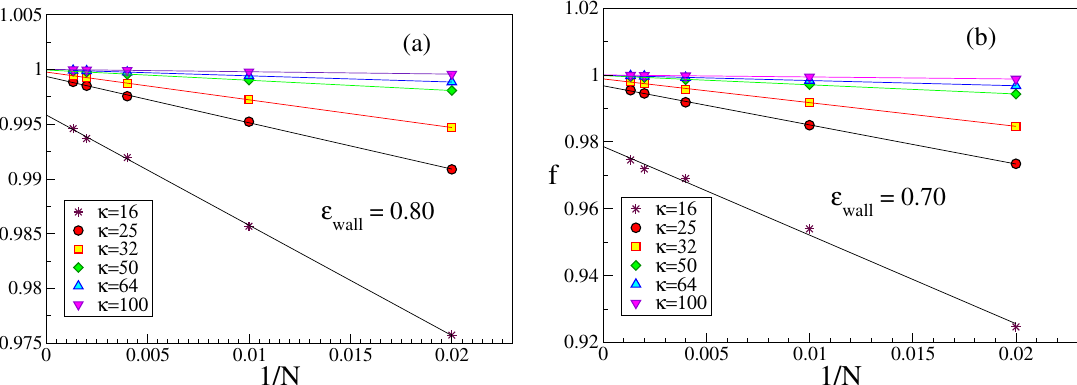
Figure 7. Plot of f vs. 1/ N for (cid:101) wall = 0.80 ( a ); and 0.70 ( b ). Straight lines through the data are tentative extrapolations. Six values of κ are included, as indicated. κ = 16 data without excluded volume are systematically larger, while for larger κ presence or absence of excluded volume does not cause appreciable difference.